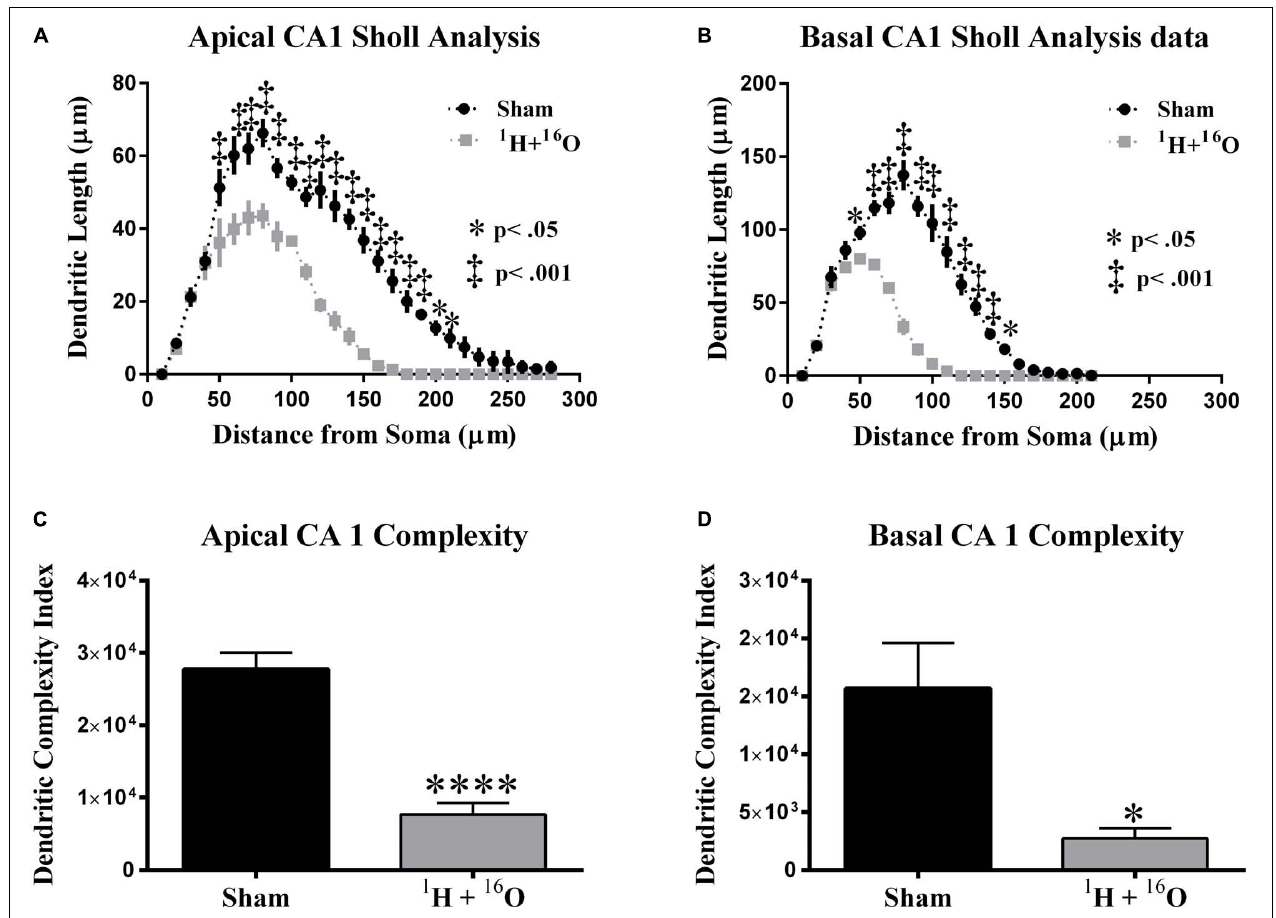
FIGURE 4 | Dorsal CA1 dendritic morphology. (A,B) The apical and basal CA1 regions had significant dendritic length reductions through broad distances from the soma. (C,D) Dendritic complexity was significantly reduced as a result of treatment in both the apical and basal divisions. Average ± SEM ( n = 5); * P < 0.05, **** P <